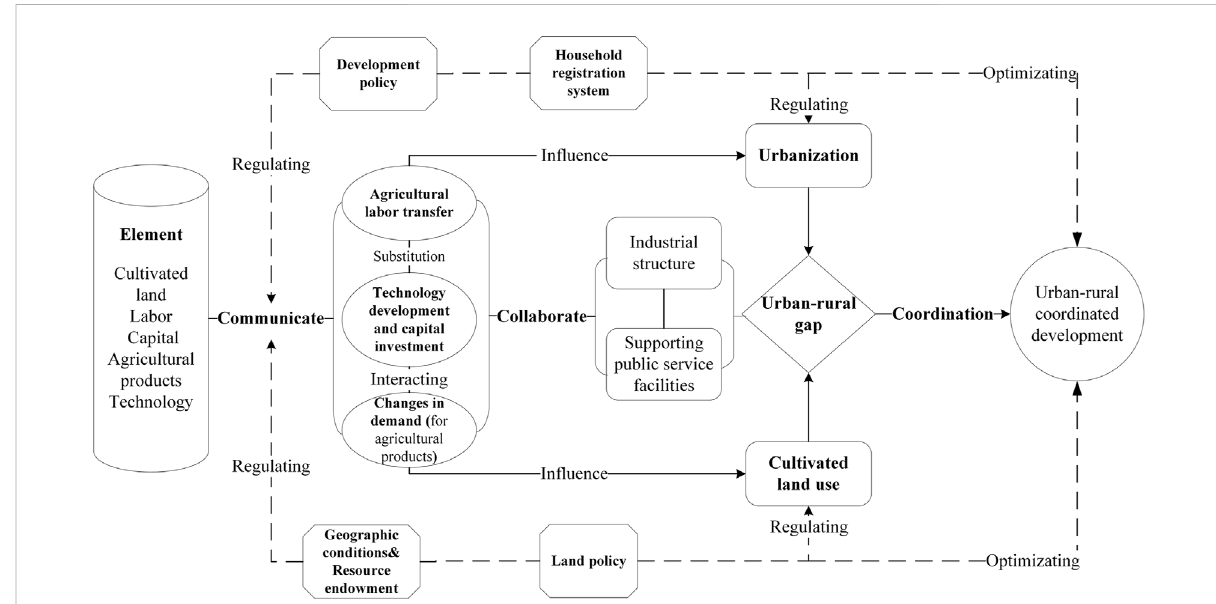
FIGURE 8 Mechanisms for urban ‒ rural coordinated development from the perspective of urbanization and CLUE